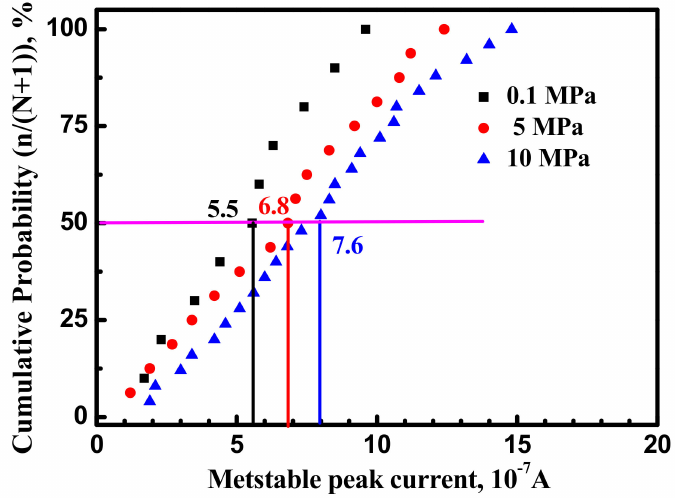
Figure 7. Cumulative distribution of metastable pits i peak for the X70 steel at various hydrostatic pressure and − 100